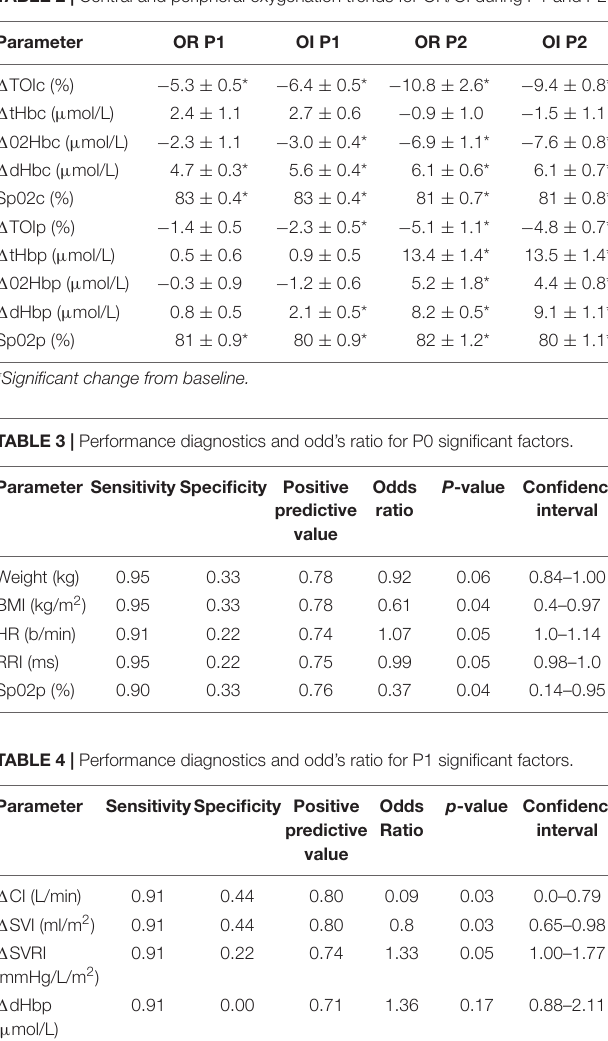
TABLE 2 | Central and peripheral oxygenation trends for OR/OI during P1 and P2.